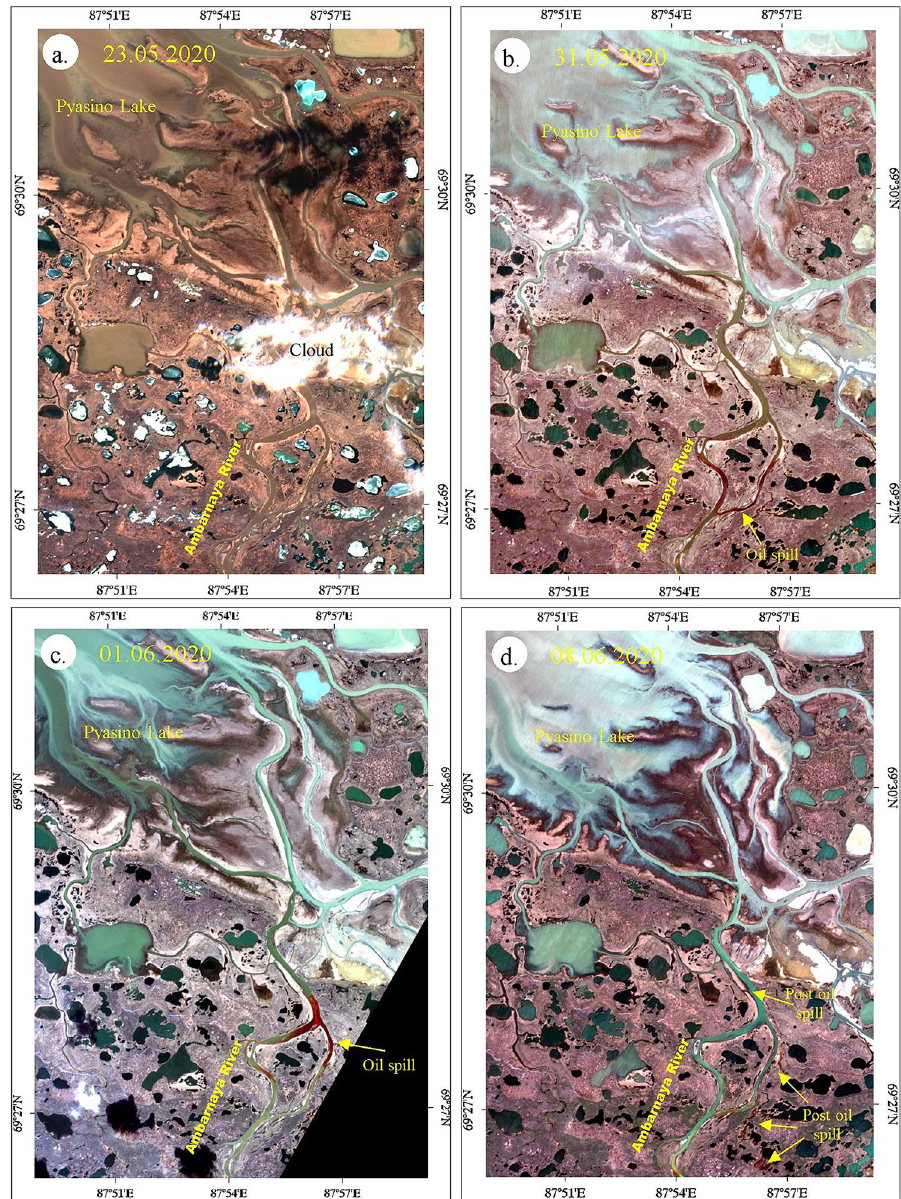
Figure 5. True color images [R:4; G:3; B:2] of Sentinel-2 ( a ) acquired on May 23, 2020 show the absence of oil spill in the Ambarnaya River and ( b ) and ( c ) acquired on May 31, 2020 and June 01, 2020 show oil spill in the river channel in crimson red, and ( d ) the image acquired on June 08, 2020 show the spilled oil in the creeks and water bodies found parallel to the river channel [ENVI 5.5 https ://www.harri sgeos patia l.com; https ://senti nel.